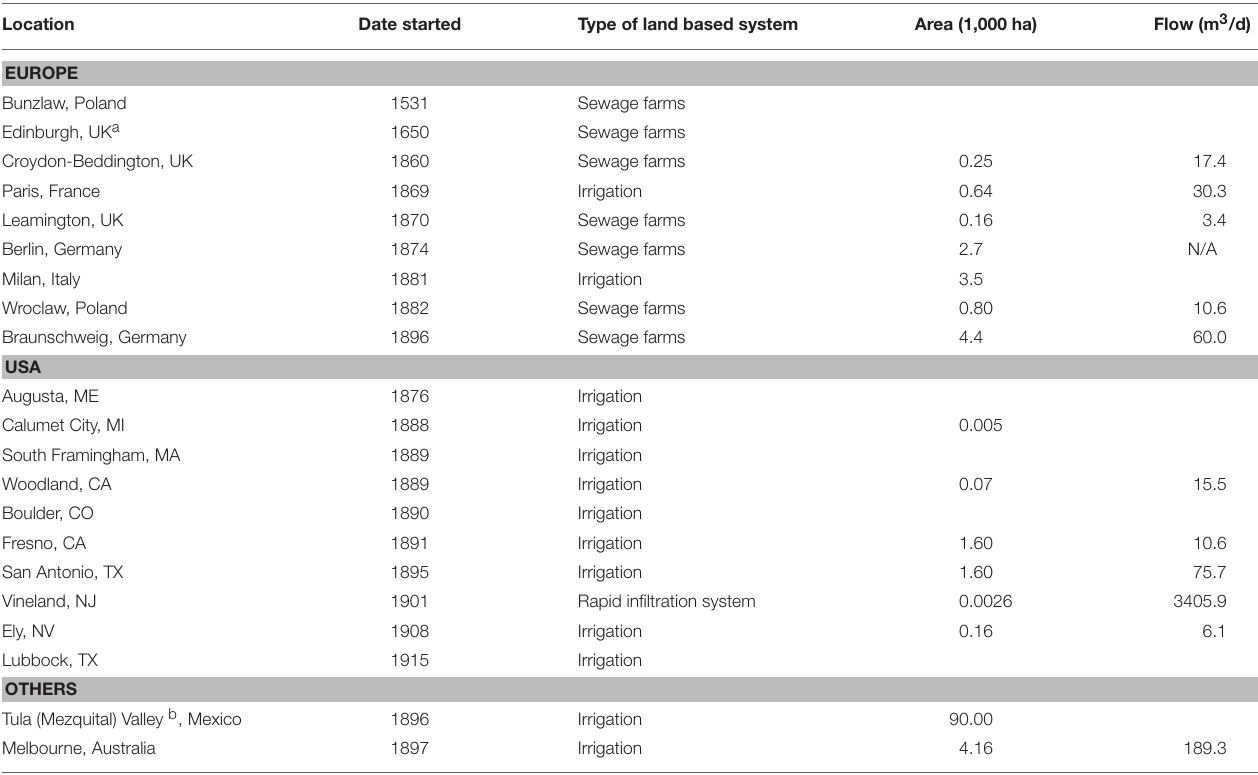
TABLE 1 | Selected early land treatments and reuse systems.